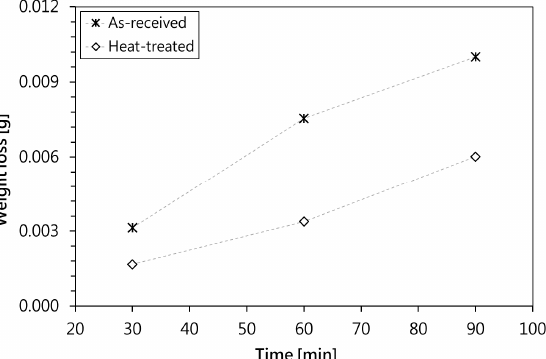
Figure 13. Erosion tests result for the as-received and heat-treated hardfacing samples: weight loss against erosion time.